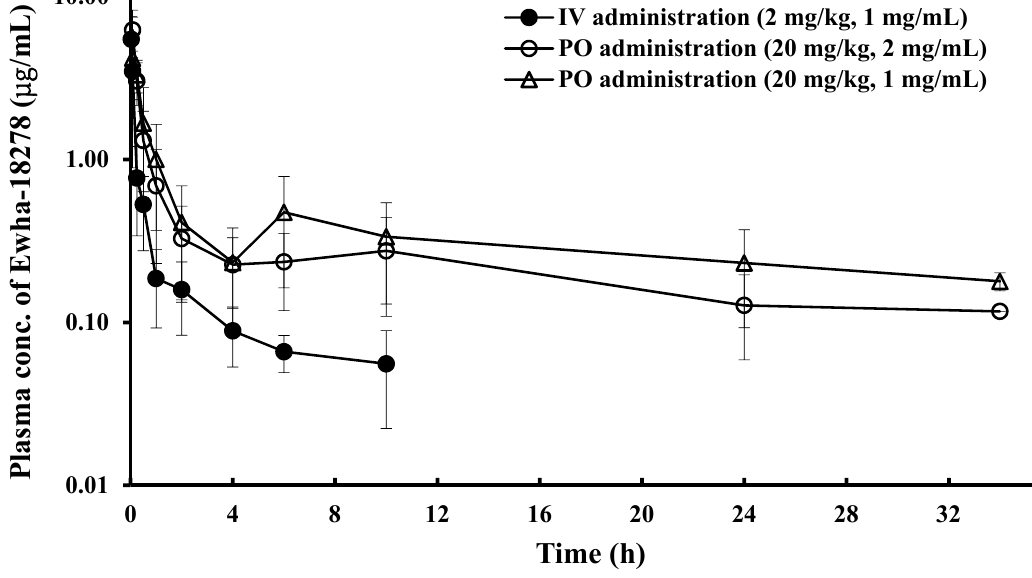
Figure 3. Mean plasma concentration-time profiles of Ewha-18278 in diazepam injection-based formulation after IV (2 mg/kg) and oral (20 mg/kg) administrations to rats. ● , IV administration; ○ , oral administration (2 mg/mL); △ , oral administration (1 mg/mL). Bars represent S.D. ( n = 5–6).